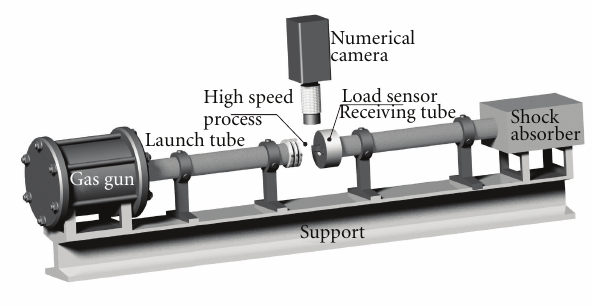
Figure 2: Ballistic setup dedicated to the dynamical friction